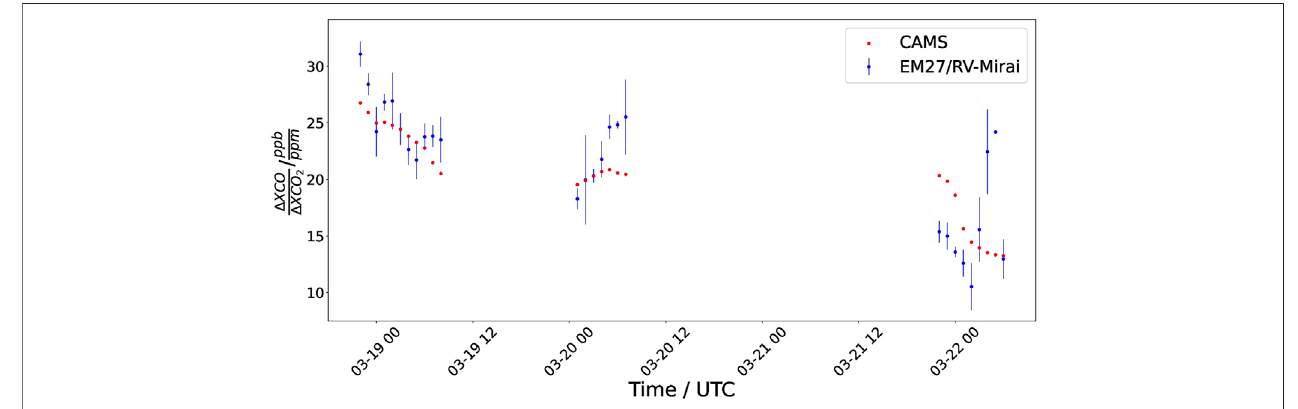
FIGURE 5 | Timeseries of the enhancement ratio Δ XCO/ Δ XCO 2 for the mobile EM27/SUN (blue) and CAMS (red) with a focus on the last period of the RV Mirai cruise.